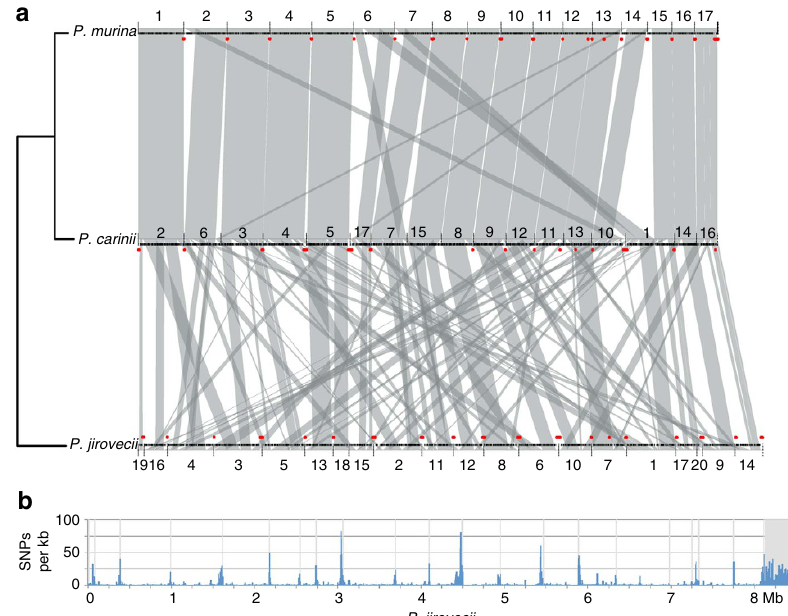
Figure 1 | Conservation of Pneumocystis genome structure. ( a ) Conserved synteny among three Pneumocystis genomes. Shared syntenic regions are depicted with grey boxes. Scaffold numbers are listed on the x -axis, and red dots indicate the location of msg genes. ( b ) Genome-wide SNP frequency between the P. jirovecii isolates from the United States (RU7) and Switzerland (SE8) 8 with the same scaffold order as in top panel. The region beyond 8Mb with a high number of SNPs is composed primarily of small scaffolds containing msg genes not assembled into the 20 large scaffolds. Using our genome assembly (RU7) as a reference, we identified a total of 24,902 SNPs, or 1 every 337 bases, between these 2 isolates, which are over-represented in subtelomeric regions where msg genes are found.